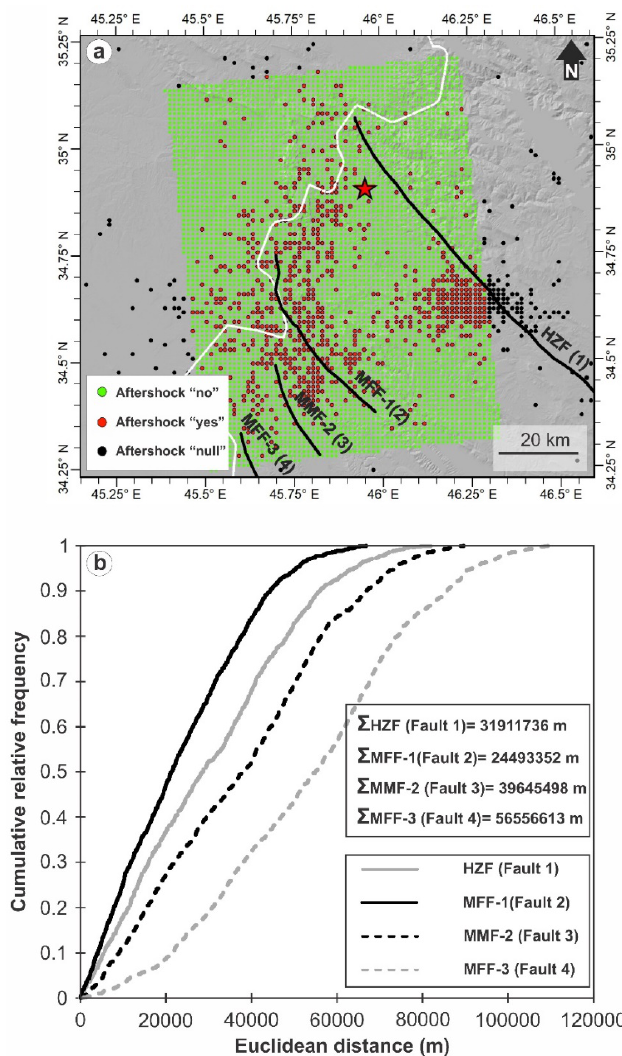
Figure 3. ( a ) Binary aftershock map of the study area with a grid resolution of approximately 1.5 km. Green and red dots represent “no aftershock” and “aftershock” statements, respectively. Black dots were not considered for the initial learning step due to the lack of overlap with the footprint of the Coulomb stress change map. ( b ) Accumulated Euclidean distance of each fault from the aftershocks.